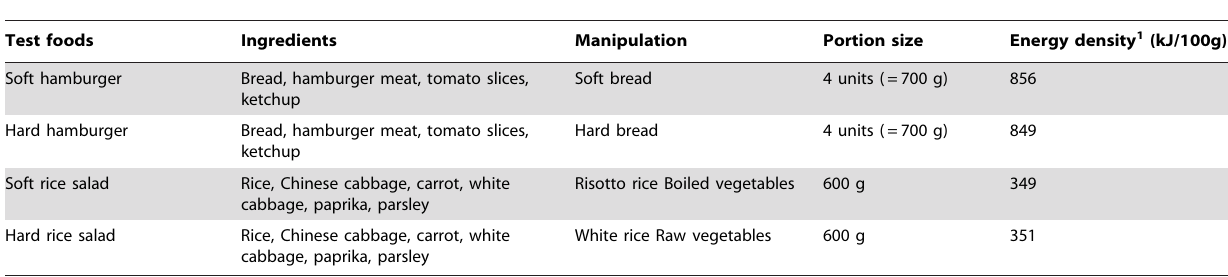
Table 1. Lunch-items used for softer- and hard foods.